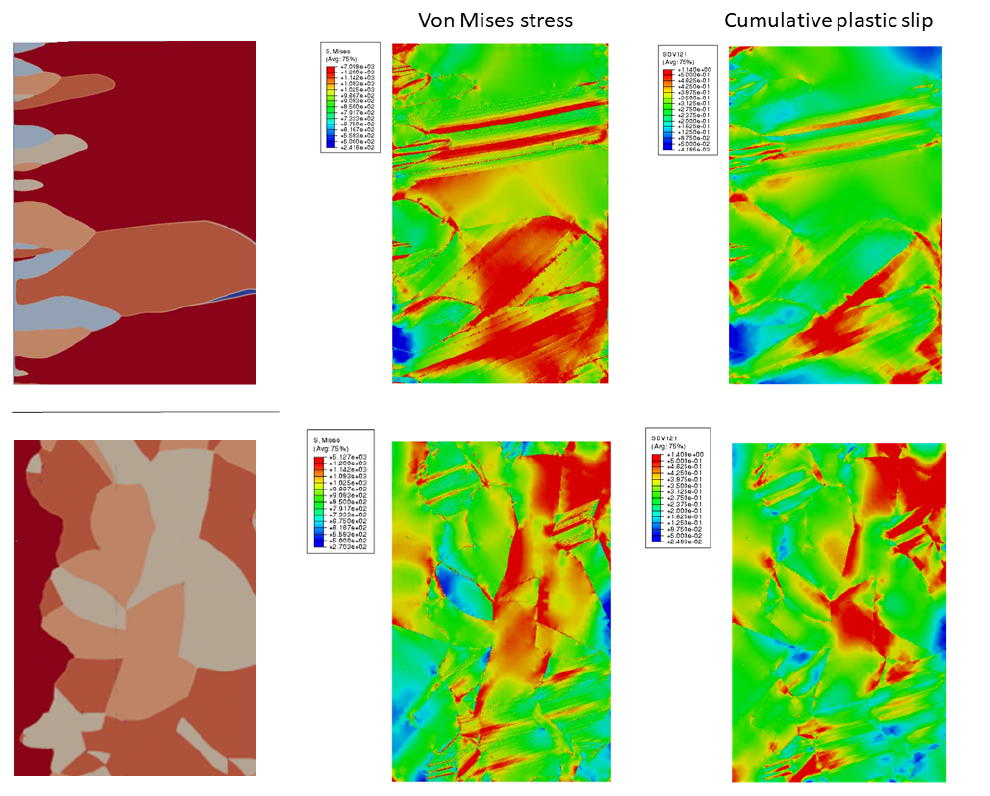
Figure 6. Epitaxial ( top ) and equiaxed ( bottom ) Ti-6-4 polycrystalline martensitic structures under tensile